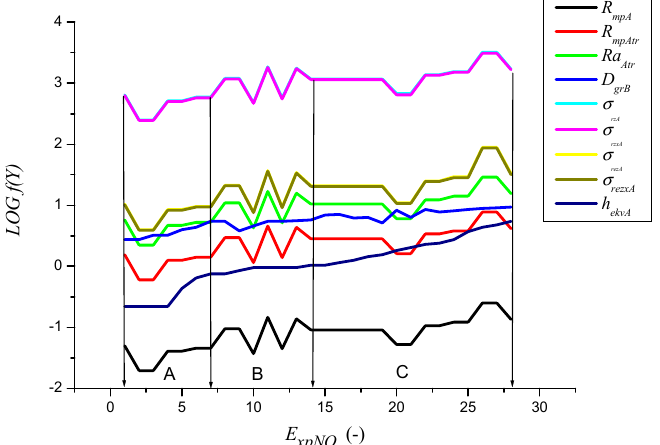
Figure 8. Adhesion A dhmp = f ( Ra , D gr ) for the combination A/B and A/C, where: Section A ( E xpNO 1-12) insufficient roughness for the desired adhesion, Section B ( E xpNO 6-21) very good roughness for the desired adhesion, Section C ( E xpNO 21-28) sufficient roughness for the desired adhesion.